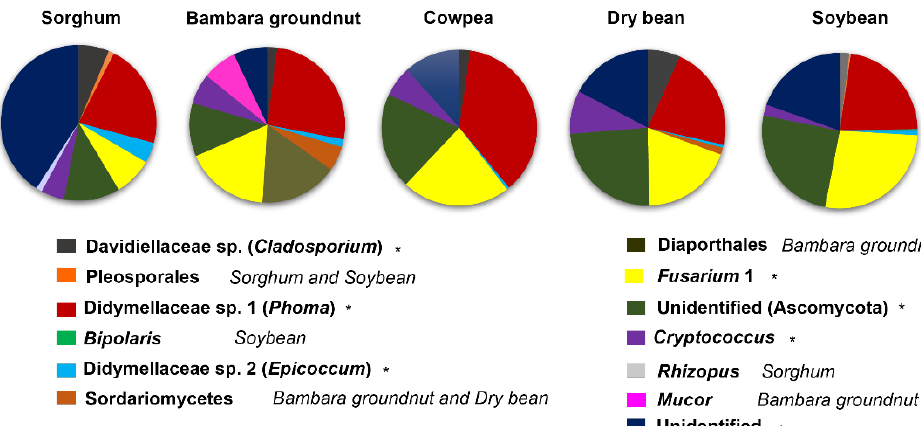
Figure 2. Fungal diversity of the core mycobiome. The pie chart illustrates the diversity richness of fungal MOTUs per crop. MOTUs with an asterisk (*) indicate the core across crops.